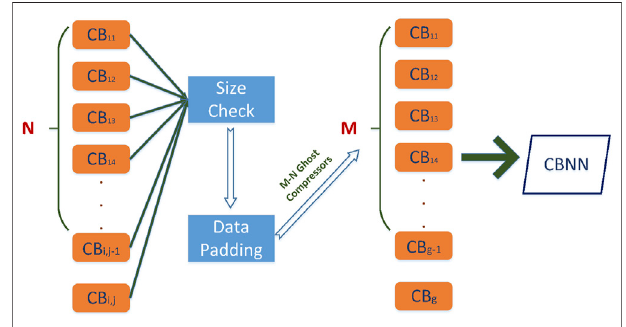
FIGURE 6 | Self-adaptive compressor padding network